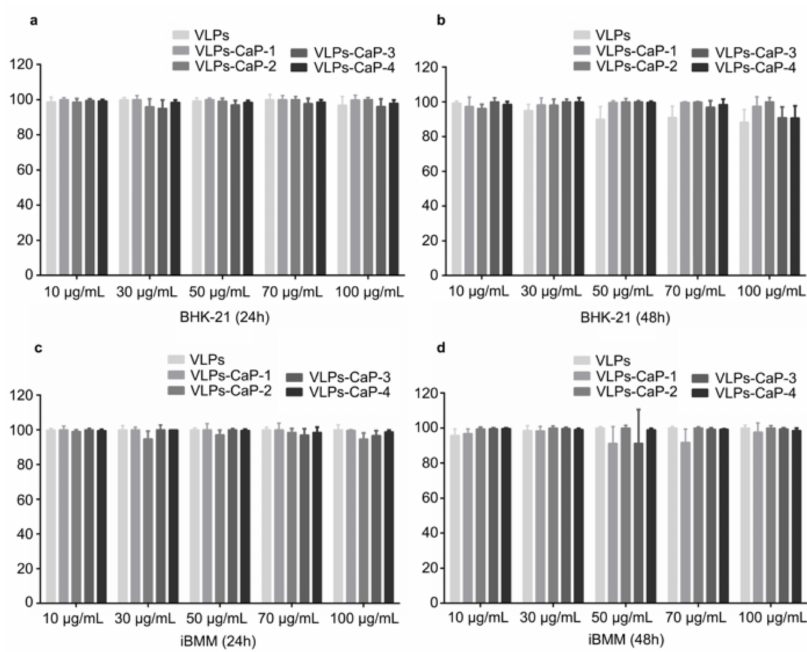
Figure 2. Cytotoxicity of the VLPs-CaP complexes. BHK-21 cells were treated with the VLPs-CaP complexes at concentrations of 10–100 µ g/mL for 24 h ( a ) and 48 h ( b ). iBMM cells were treated with the VLPs-CaP complexes at concentrations of 10–100 µ g/mL for 24 h ( c ) and 48 h ( d ). Multiple comparisons were performed using one-way ANOVA, followed by Bonferroni’s post-test, and p values <0.05 were considered